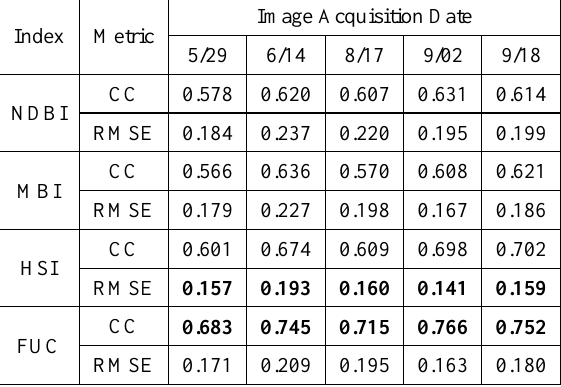
Table 1. Correlation assessment prior to thermal sharpening